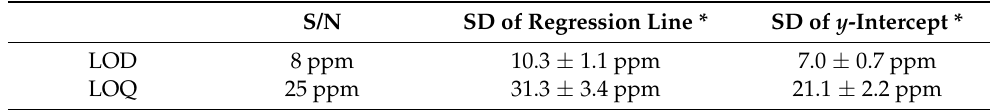
* Mean ± SD of calibration curves on three separate days.